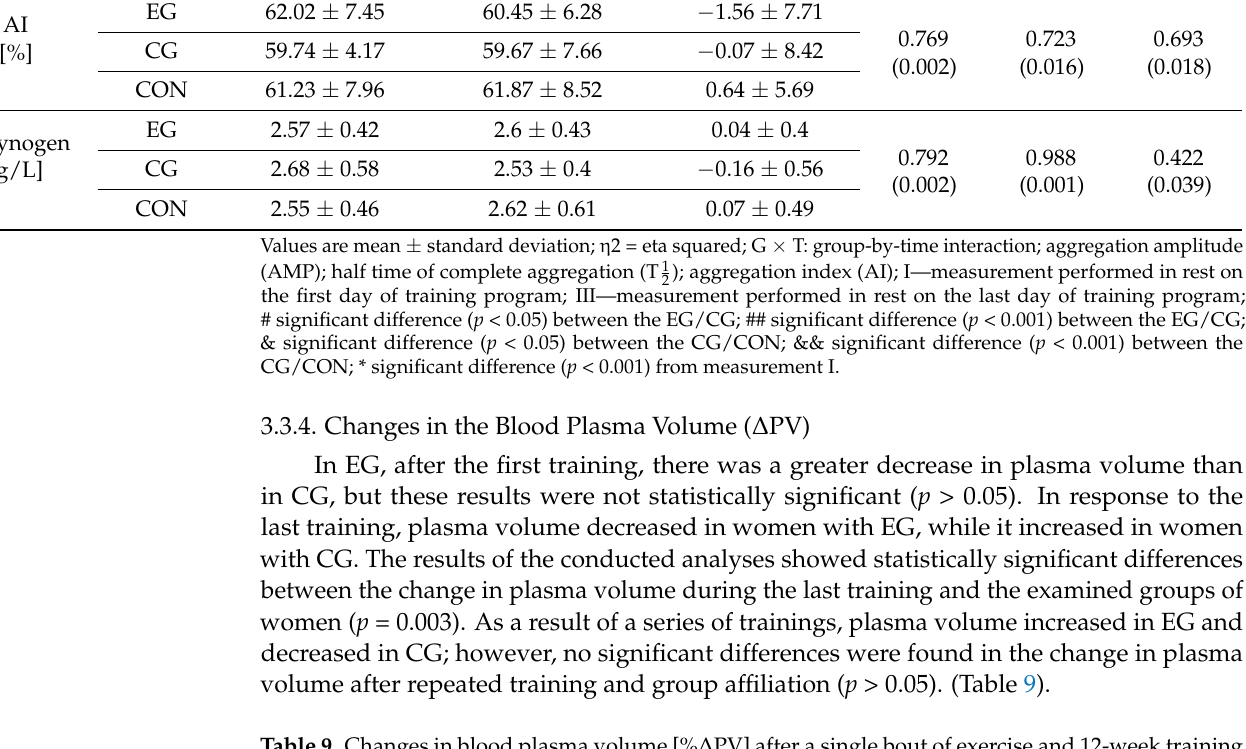
Table 9. Changes in blood plasma volume [% ∆ PV] after a single bout of exercise and 12-week training program in experimental group (EG) and comparison group